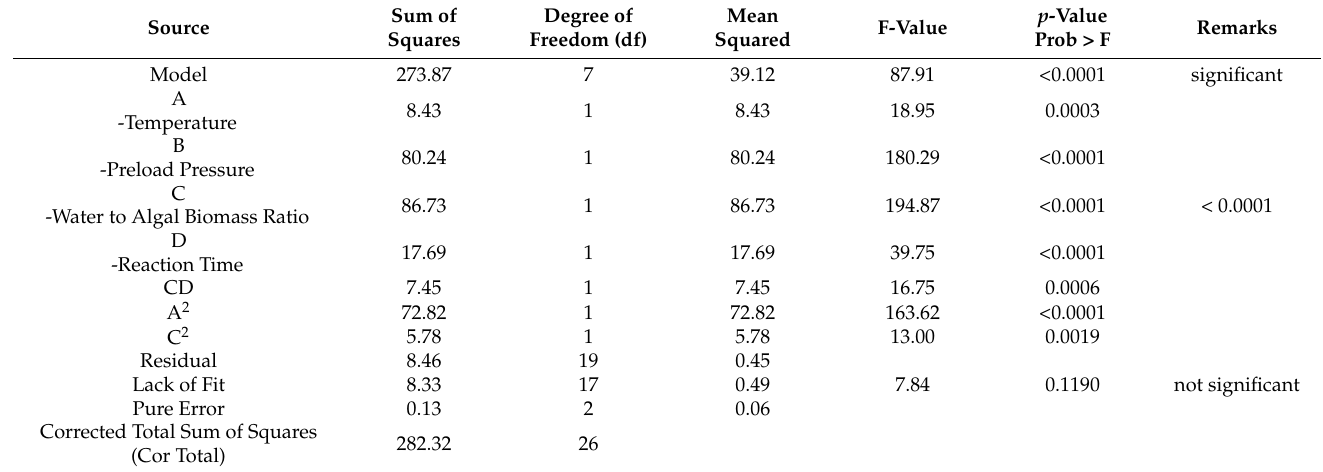
Table 7. ANOVA table for response, phenolic yield.